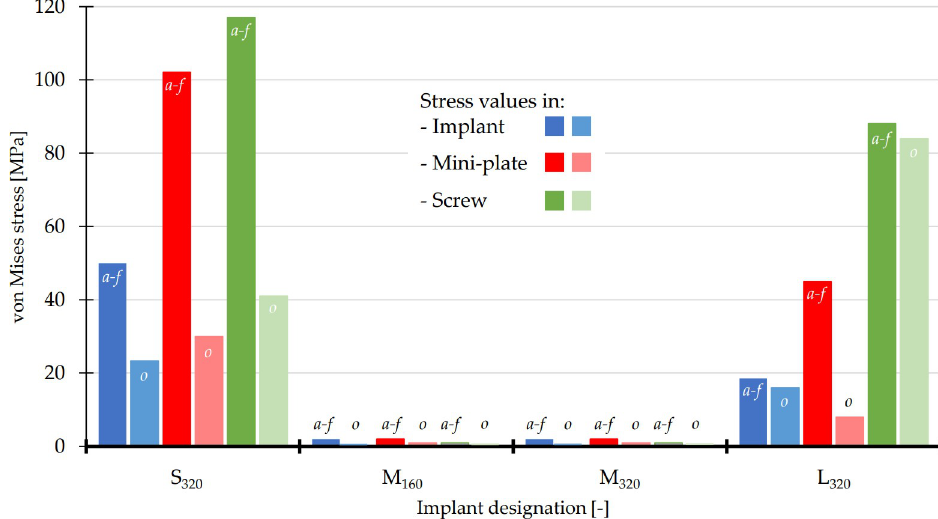
Fig 6. The maximum values of von Mises stresses in implant (blue colors), fixation mini-plates (red colors) and screws with micro-thread (green colors). The values of as-fixed state were labeled with ,, a-f ” and the values of partly osseointegrated state ( FC = 0.75) with ,,o”.